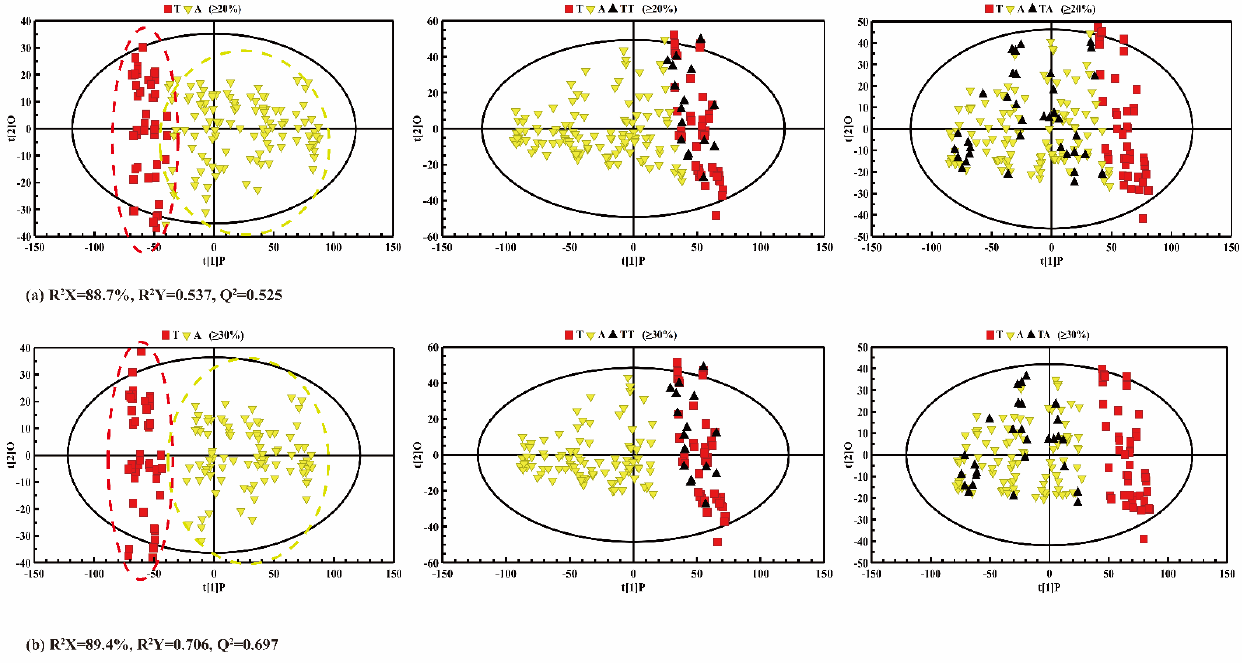
Figure 7. OPLS-DA score plots for discrimination analysis with adulteration ratios ranging from ( a ) 20% to 100%; ( b ) 30% to 100%. Left panel: training data set between the true camellia (CA) and the adulterated CA. Middle panel: the prediction of the true CA. Right panel: the prediction of adulterated samples (T: true CA; A: adulterated CA; TT: test set of true CA; TA: test set of adulterated CA).